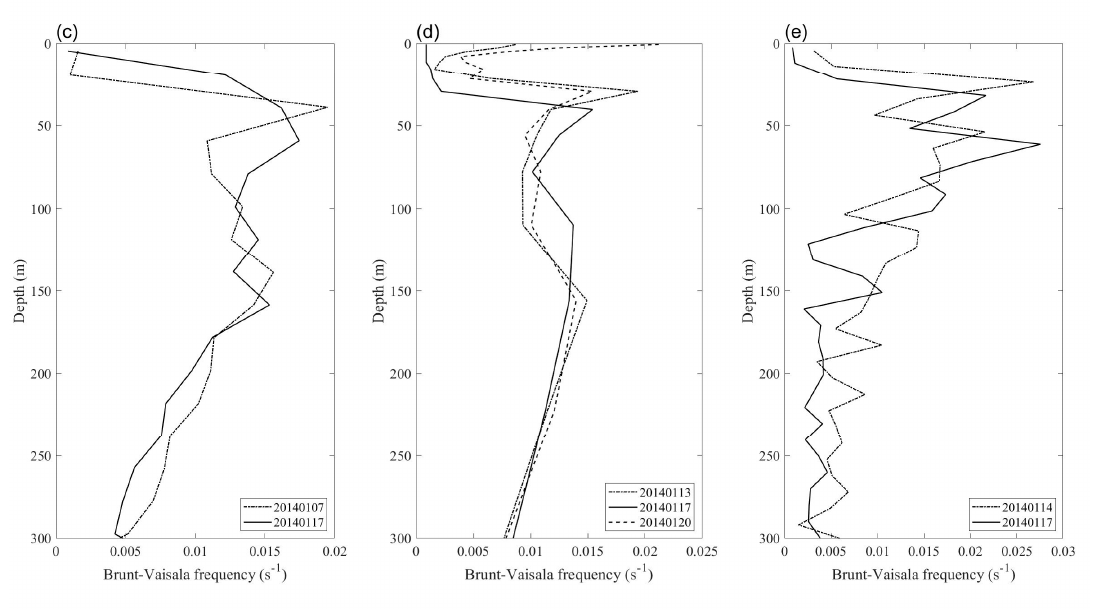
Figure 6. The MLD and Blast–Vaisala frequencies changed during the TS. (a–b) are the MLD distribution on January 13 and 17, 2014; (c–f) are Brent-Vaisala frequencies for Argo data (1900270), reanalysis data, and CTD data (1901337), respectively.